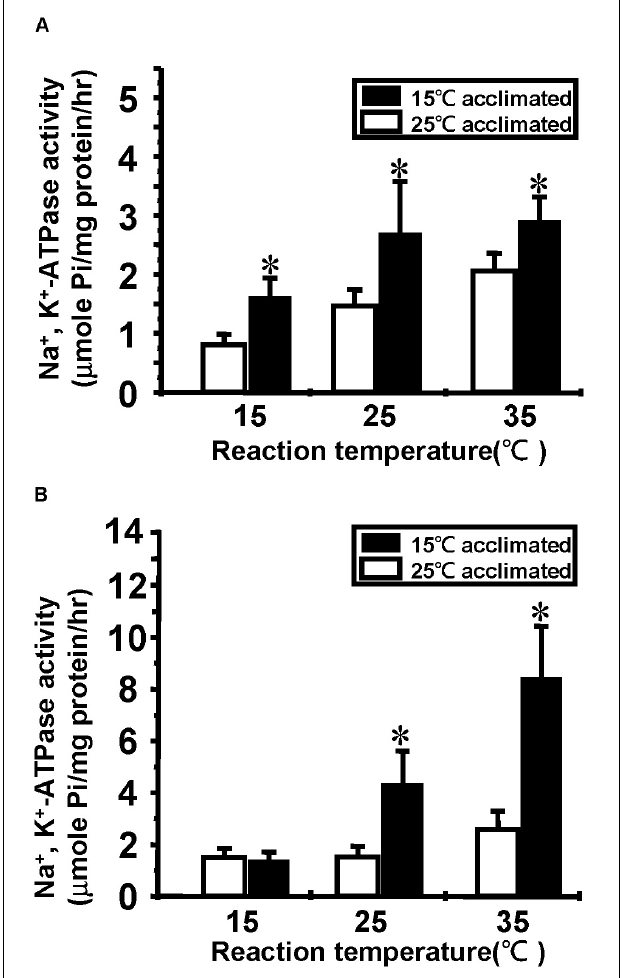
FIGURE 4 | Effect of cold acclimation on the Na + /K + -ATPase activity in tilapia or goldfish gill. Na + /K + -ATPase activity was determined in 15 ◦ C and 25 ◦ C acclimated (A) goldfish or (B) tilapia at three reaction temperatures (15, 25, and 35 ◦ C). Asterisks indicate significant differences between the two acclimation temperature groups with Student’s t -test, p < 0.05, n =